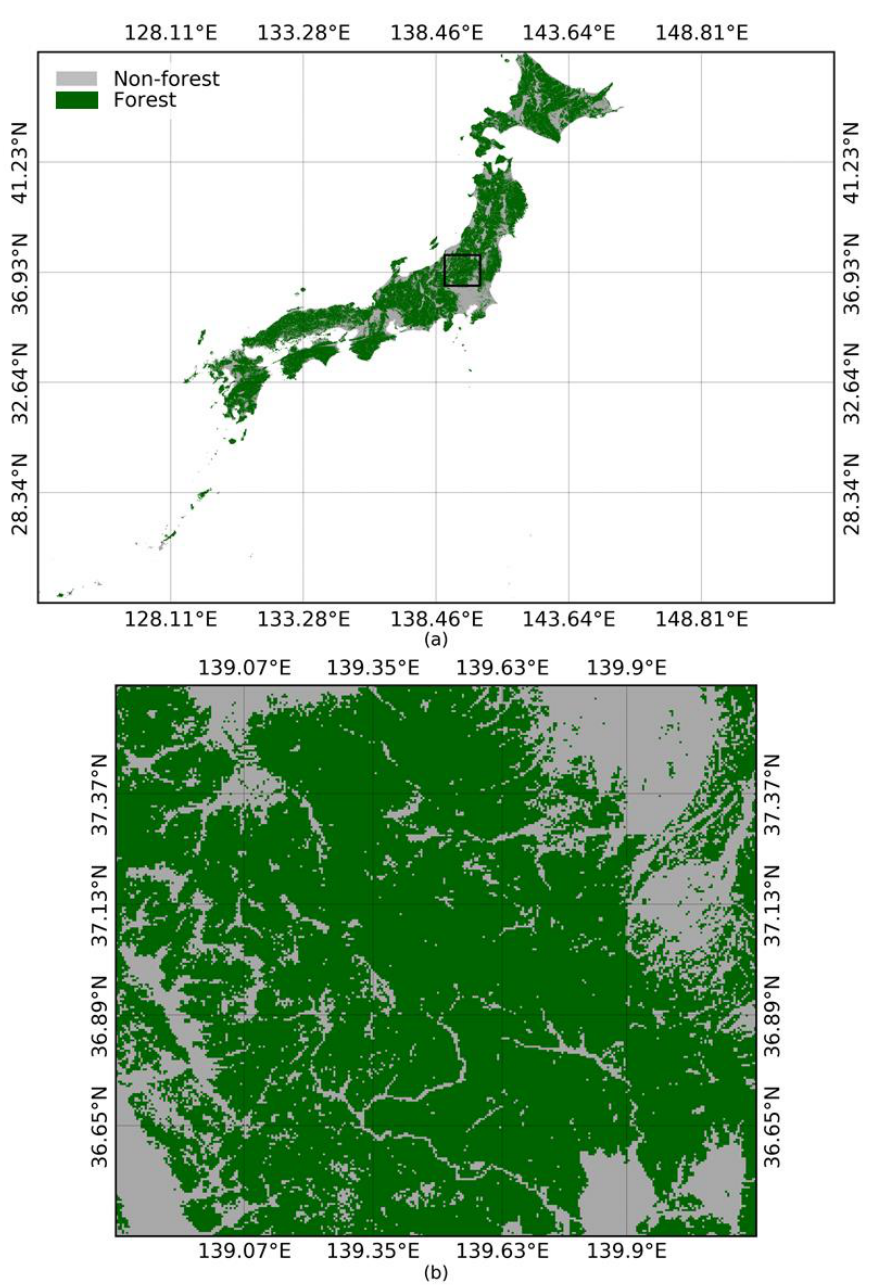
Figure 2. Countrywide forests and non-forests map produced in the research. ( a ) Display over the national territory; ( b ) magnification of the black polygon region in (a). The national boundary is based on the Global Administrative Areas database (GADM) version 3.6, May 2018.